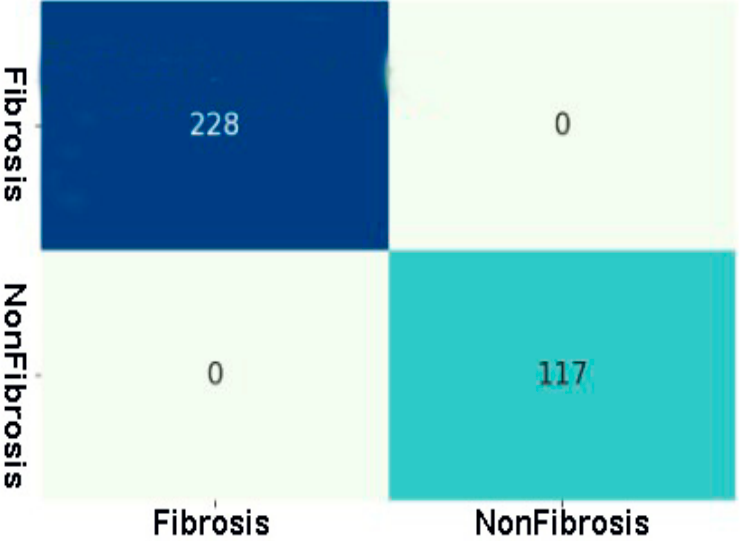
Figure 13. Confusion matrix of Fibrosis and Non-Fibrosis classes of the testing CT scan image dataset using the best performing ResNet50v2 model.